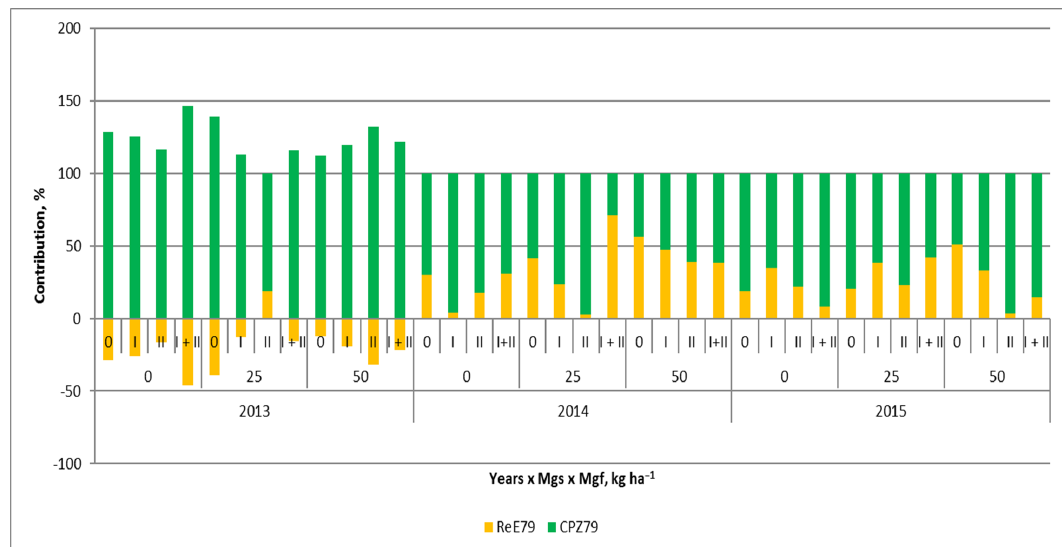
Figure 11. Effect of magnesium fertilization systems, on the background of years, on contribution of the remobilized dry matter and the current photosynthesis in the temporary grain yield at BBCH 79. Legend: Mgs, Mgf—soil and foliar Mg fertilization systems, respectively; I—BBCH 30; II—BBCH 49/50.